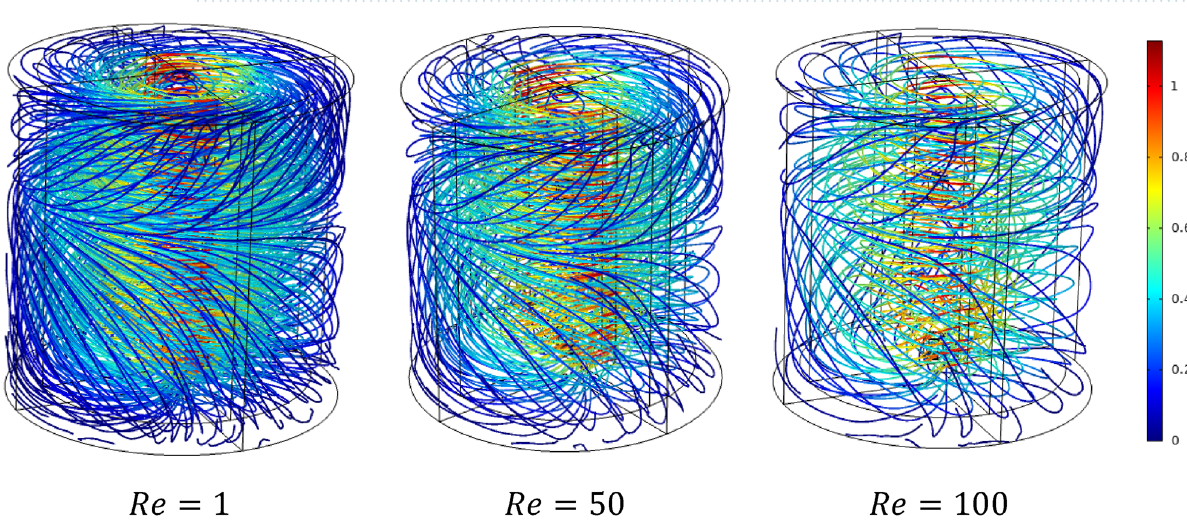
Figure 21. Streamline distribution along stirred vessel for Bn = 1 with inertia variation values.